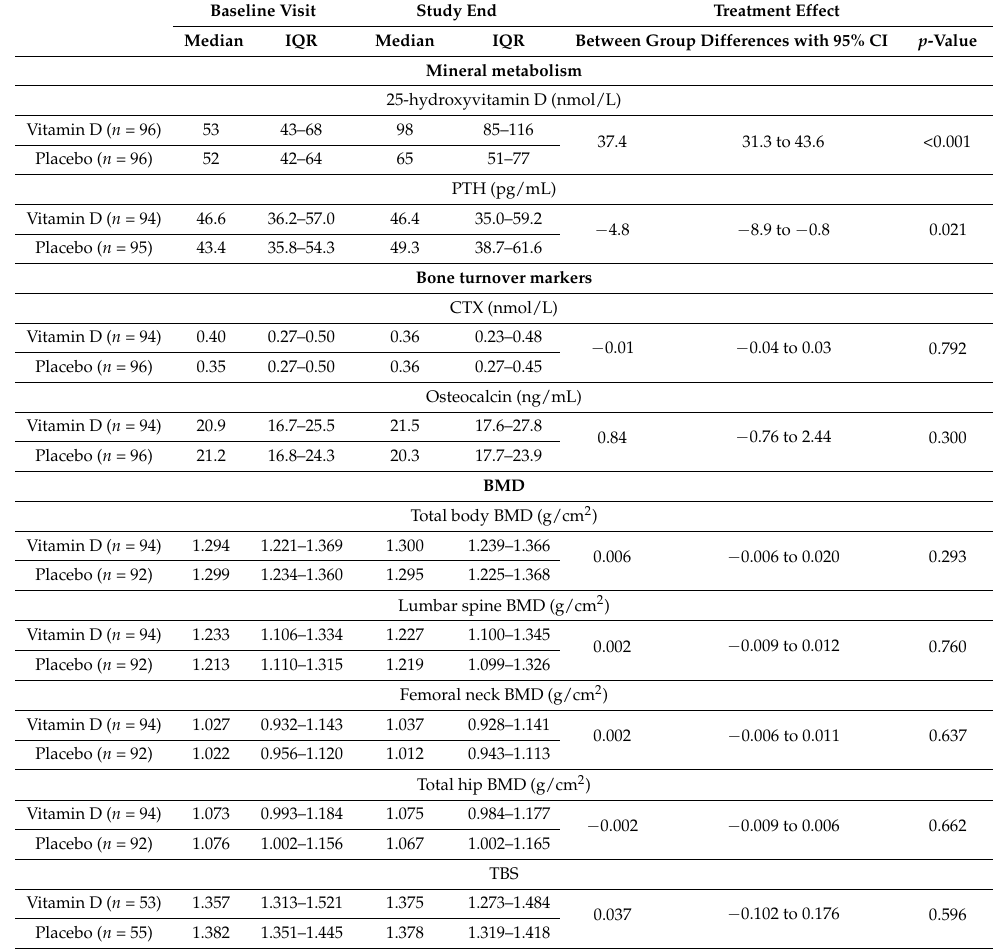
Table 2. Parameters of mineral metabolism and outcome variables at baseline and final follow-up at study end (12 weeks) in study participants with available values at both study